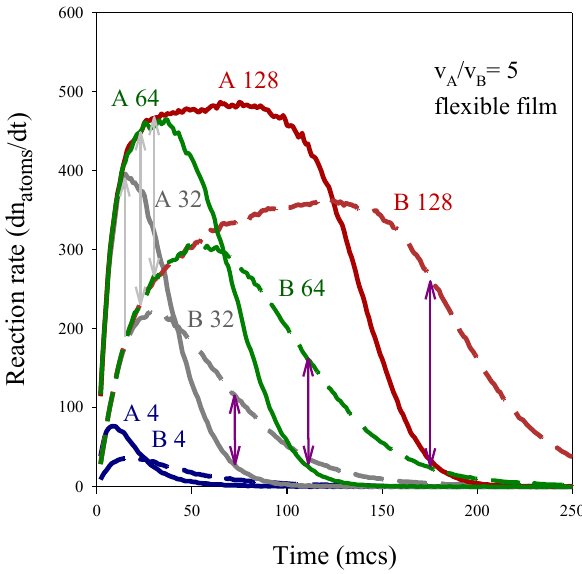
Figure 4. Reaction rate vs. time. Continuous and discontinuous lines show the reaction rate of fast (A) and slow (B) metals respectively. Synthesis conditions: reduction rate ratio v A /v B = 5; flexible film ( k ex = 5, f = 30). Metal salt concentration:  c  = 128, 64, 32 and 4 metal salt in a micelle are represented by red, green, grey and blue lines